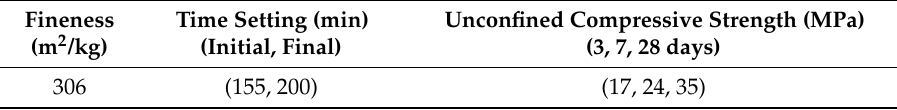
Table 4. Physical and mechanical properties of type V Portland